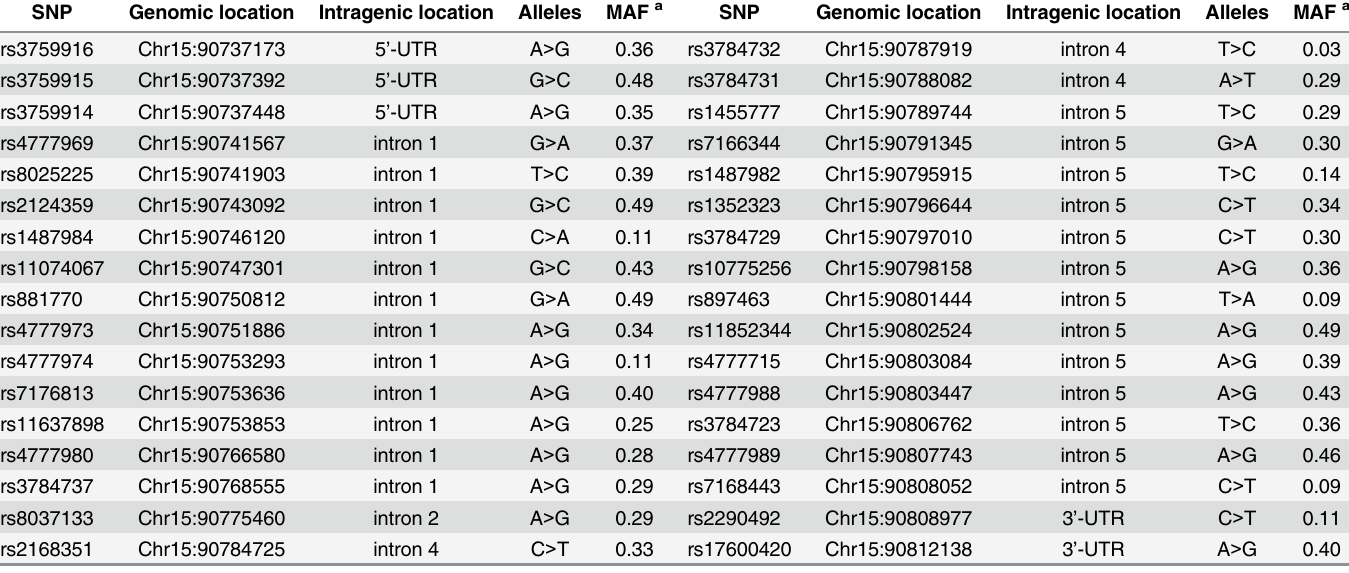
Table 1. Characteristics of the 34 ST8SIA2 tag SNPs. SNP Genomic location Intragenic location Alleles MAF